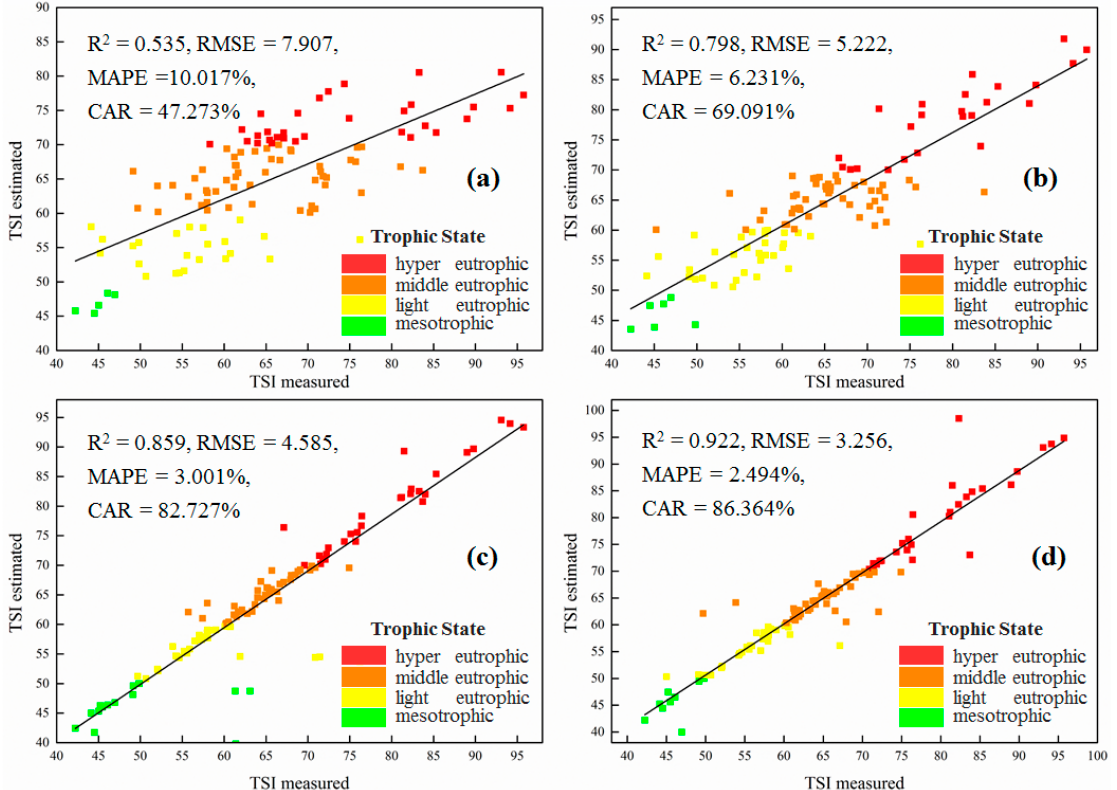
Figure 7. Performance of the BP-NN-based TSI estimation model for the following tests: R rs only ( a ), T-R rs combined ( b ), WT and WD-R rs combined ( c ), and WT-R rs combined ( d ).